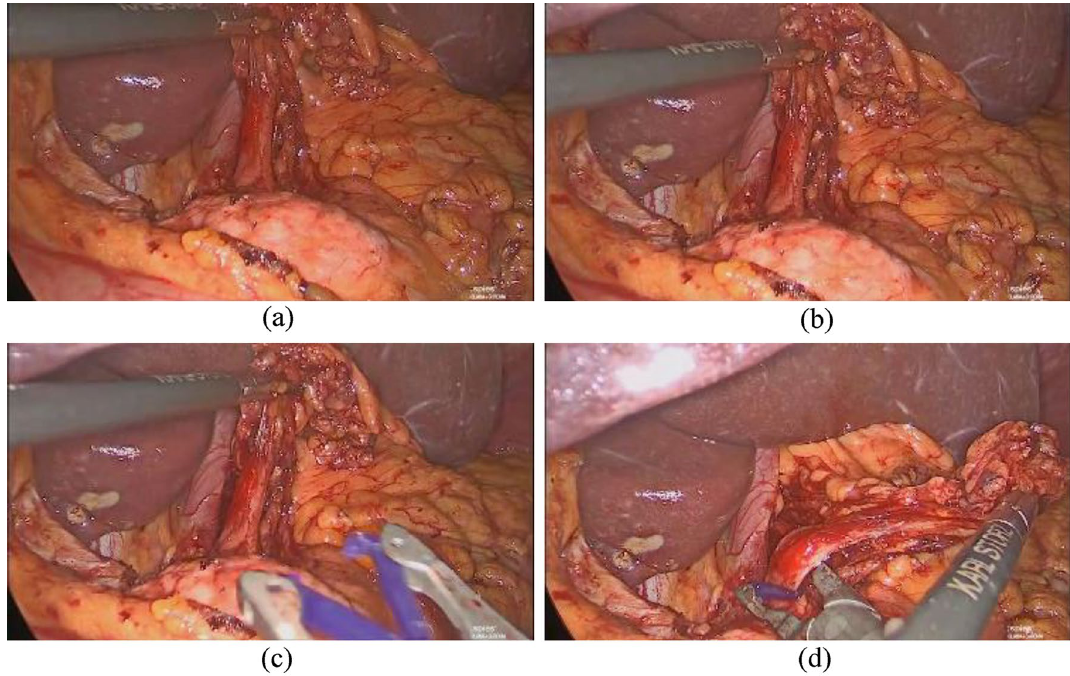
Figure 2. Images used as start frames for the four scenes. Frame number ( a ) 20, ( b ) 200, ( c ) 400, and ( d ) 600 of the